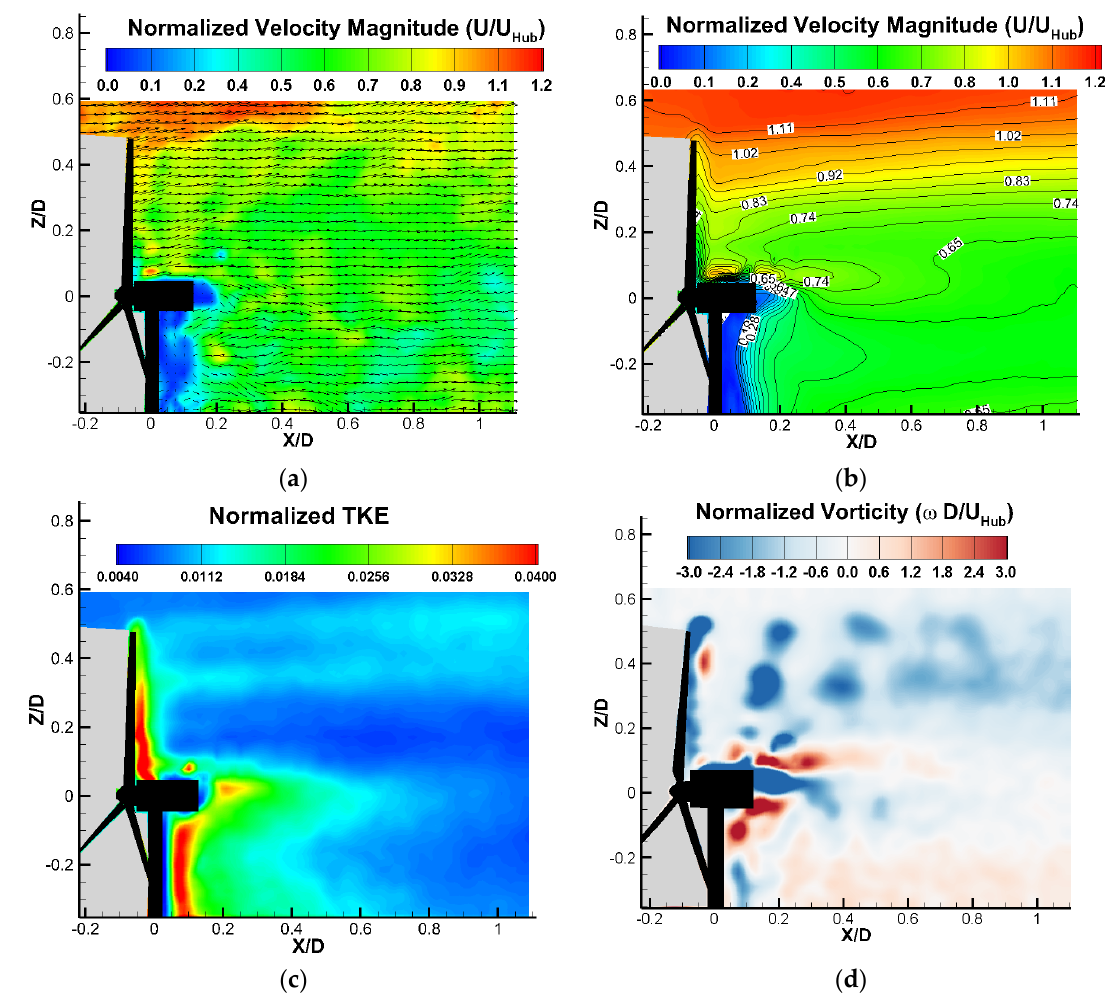
Figure 5. ( a ) Velocity magnitude of an instantaneous PIV measurement, ( b ) ensemble-averaged normalized velocity, ( c ) ensemble-averaged normalized TKE and ( d ) phase-averaged normalized vorticity for rotation phase angle of 0°.